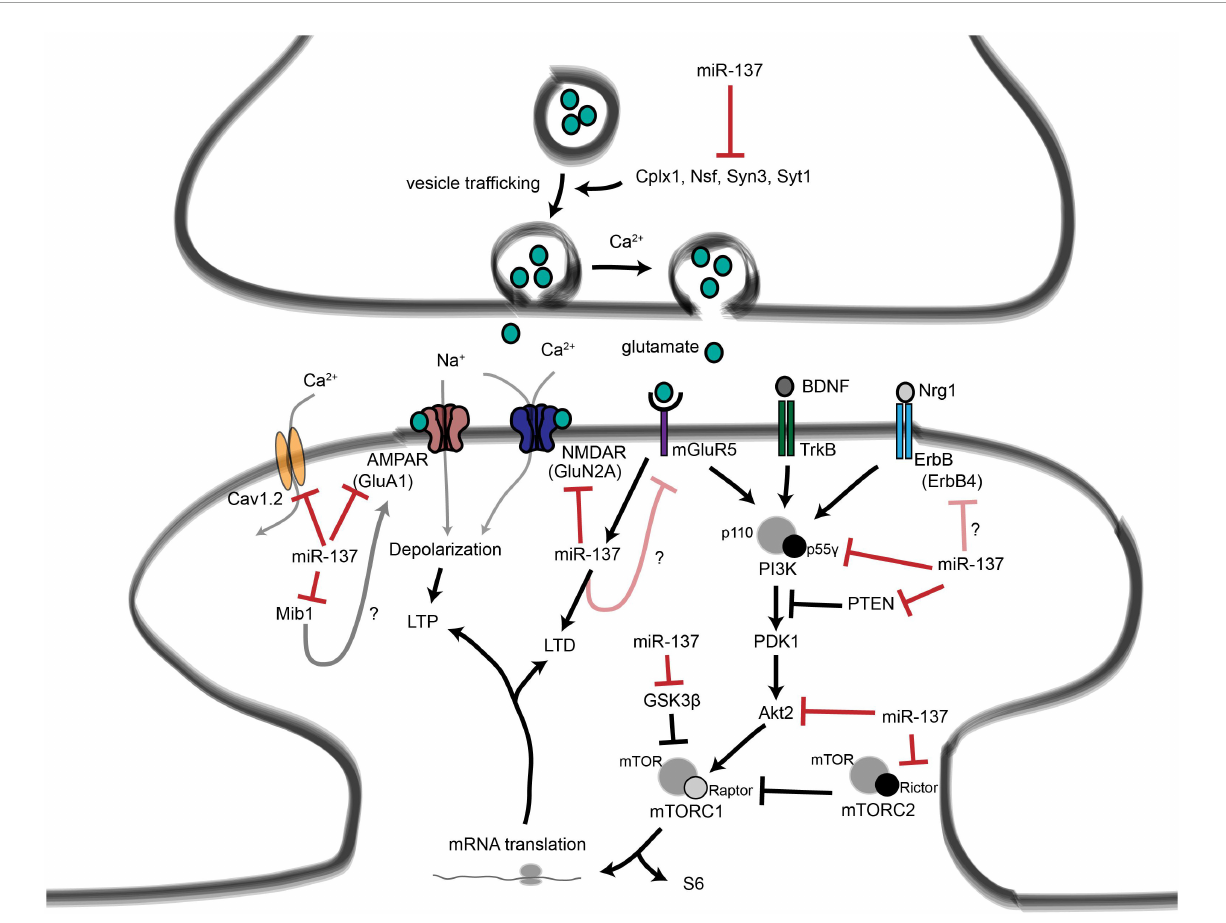
FIGURE15 Roles for miR-137 at the glutamatergic synapse. This figure summarizes the findings of Kwon et al. (2013), Zhao et al. (2013), Olde Loohuis et al. (2015), Siegert et al. (2015), and Thomas et al. (2017). miR-137 regulates presynaptic signaling by regulating vesicle trafficking in the axon terminal. miR-137 also targets the mRNA that encodes the L-type calcium channel subunit Cav1.2 (CACNA1C), which has also been linked to schizophrenia with genome-wide significance. Postsynaptically, miR-137 regulates the levels of glutamatergic receptor subunits GluA1 (GRIA1) and GluN2A (GRIN2A), and bioinformatic predictions suggest that miR-137 may target the metabotropic glutamate receptor mGluR5 (GRM5) as well as ErbB4, which regulates the strength of glutamatergic synapses. mGluR5 signaling, in turn, increases miR-137 levels. miR-137 also regulates proteins within the PI3K-Akt-mTOR pathway, e.g., p55g, to regulate neuronal responses to BDNF and Nrg1 signaling. miR-137 may regulate PI3K-Akt-mTOR signaling downstream of mGluR receptors as well. Figure from Thomas et al. (2018), obtained under a creative commons license 3 and